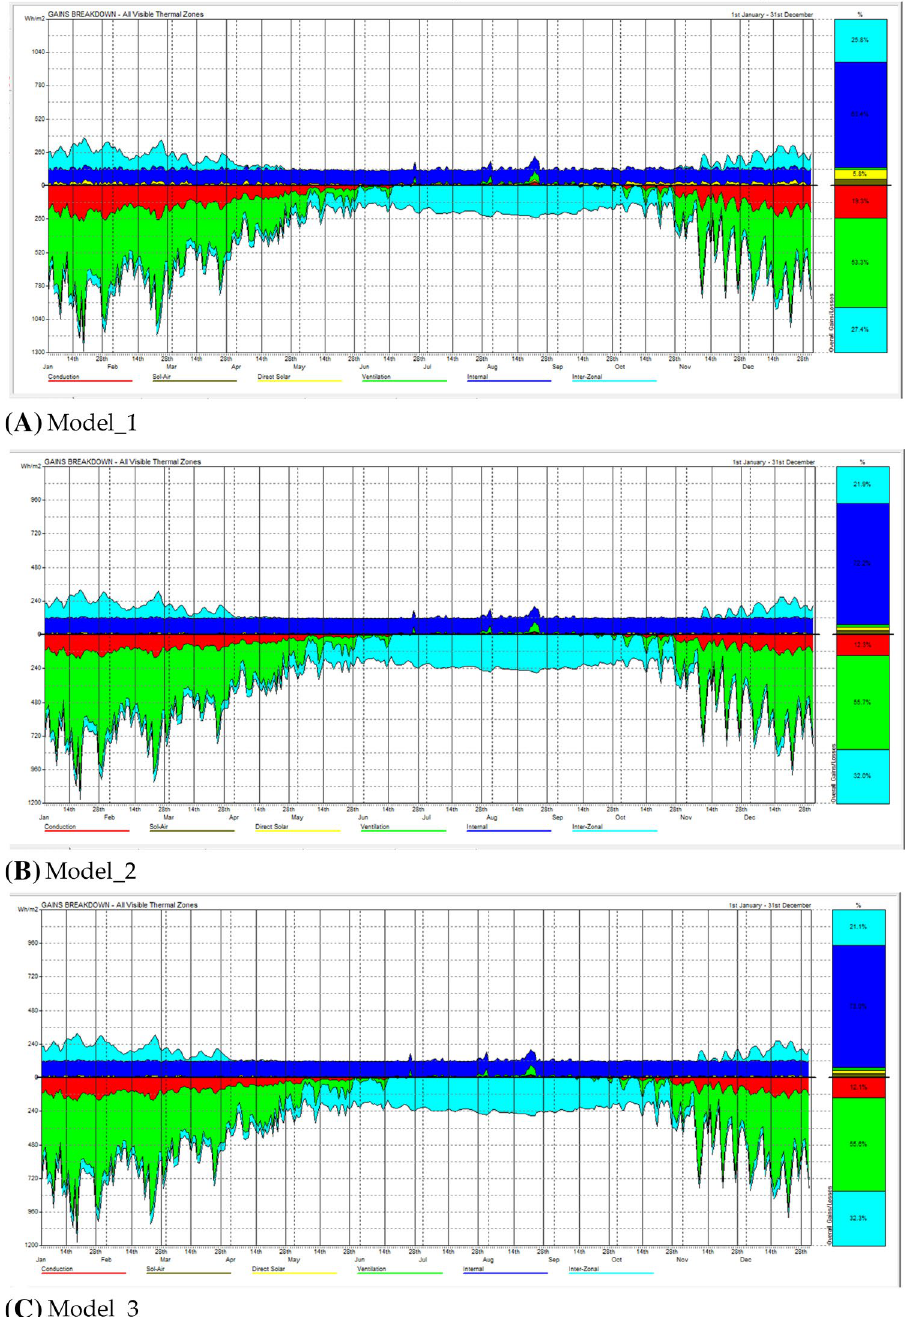
Figure 11. The passive grains breakdown analysis. ( A ) Model_1; ( B ) Model_2; ( C )